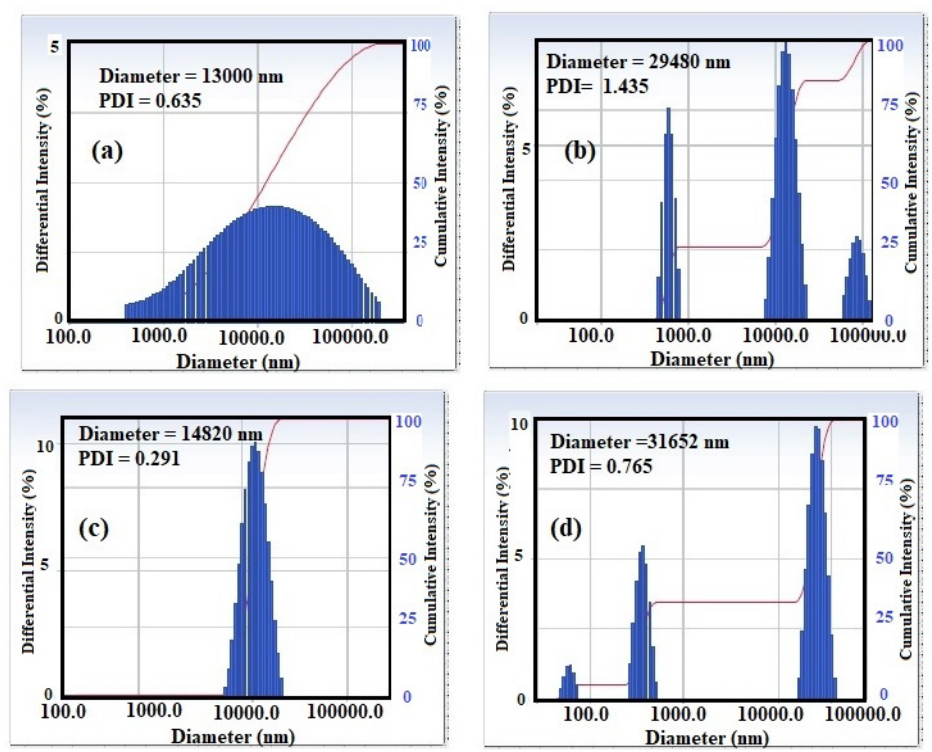
Figure 4. Dynamic light scattering of dispersed ( a ) SG, ( b ) ASG, ( c ) STHc and ( d ) STHa in polyamine hardener solution.